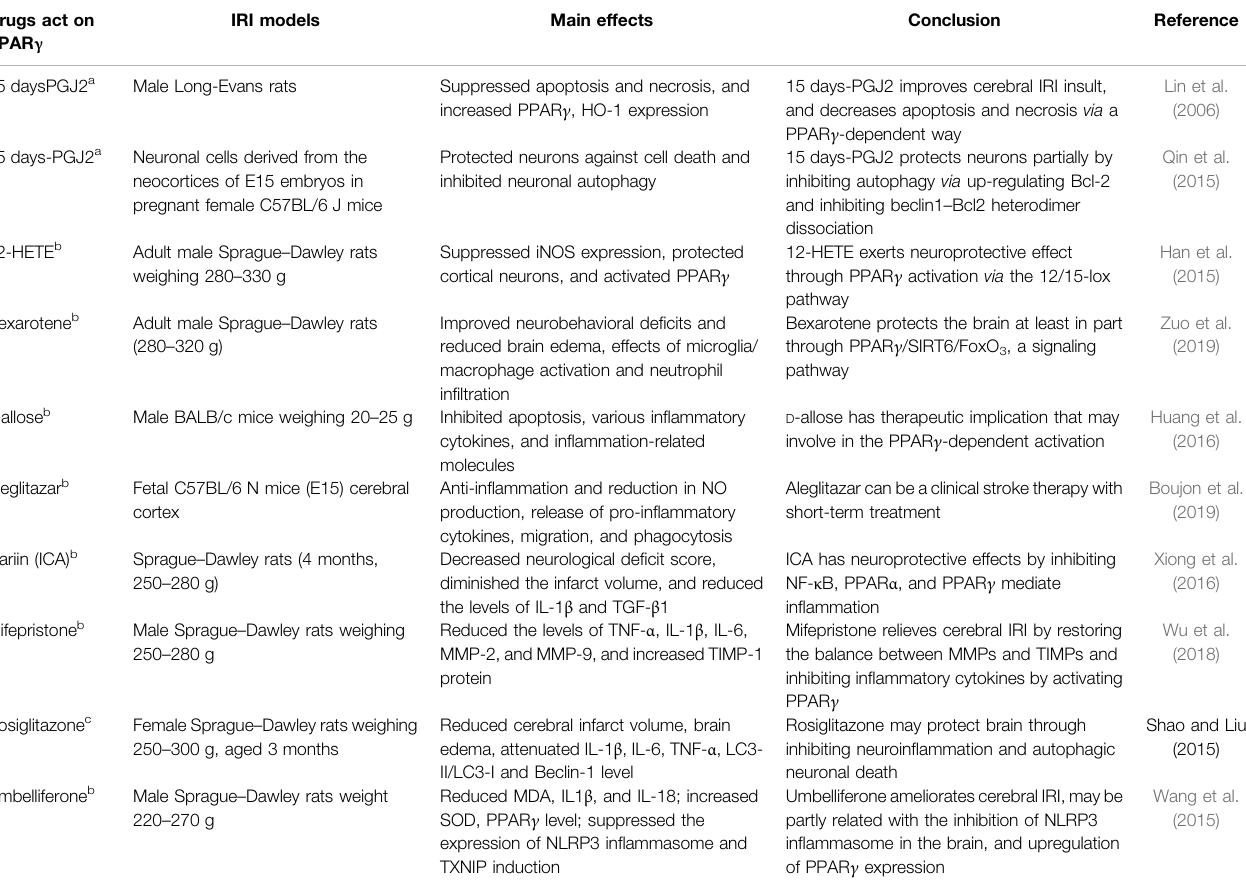
TABLE 3 | Summarization of the effects of drugs acting on PPAR γ in cerebral IRI. Drugs act on PPAR